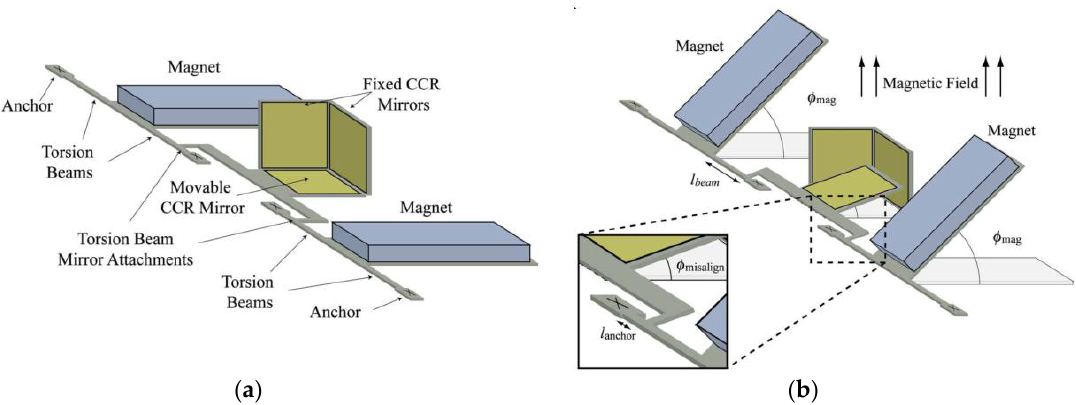
Figure 20. Schematic of a MEMS magnetic field sensor composed of a CCR: ( a ) without; ( b ) with an external magnetic field. In addition, a close up view of the coupling between the mirror and torsion beam is shown [32]. Reprinted with permission from [32]. Copyright© 2007, IEEE.